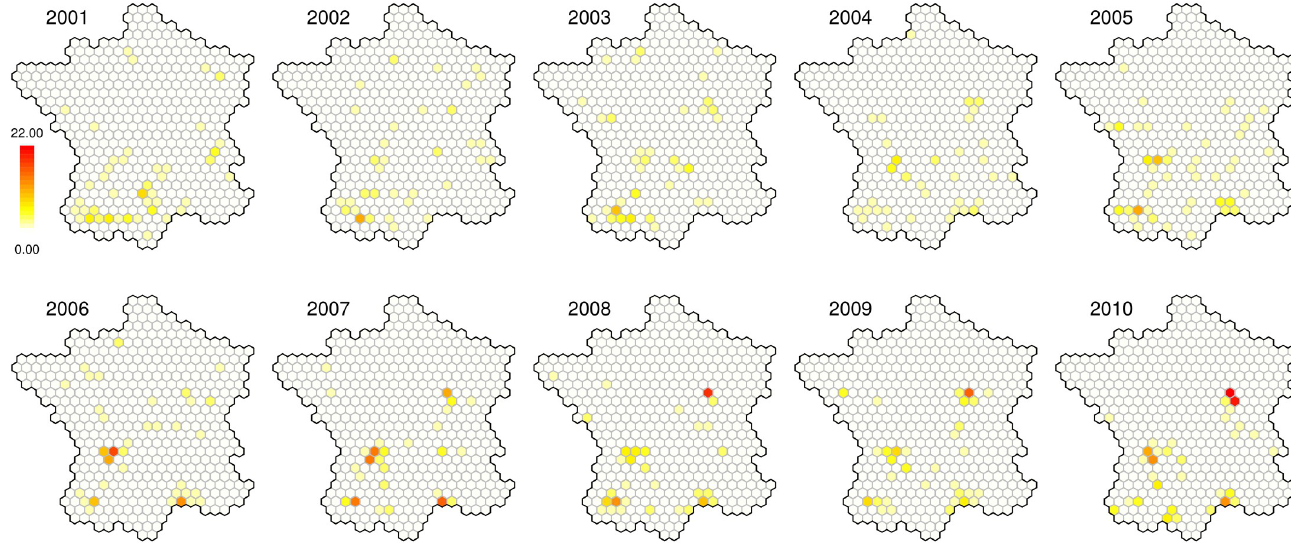
Fig 1. Evolution of the repartition of bovine tuberculosis cases over the years.